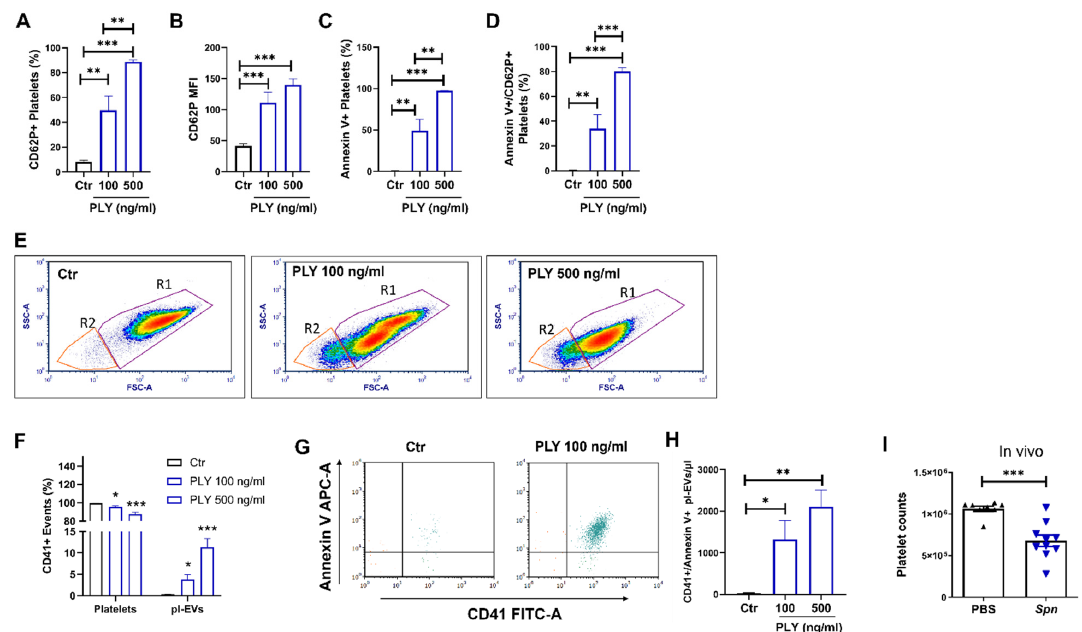
Figure 5. Pneumolysin activates platelets and induces the release extracellular vesicles (pl-Evs). ( A – H ) Human platelets (diluted PRP) were stimulated with PLY (100 or 500 ng/mL, 30 min), stained with CD62P (PerCP) antibody or annexin V (APC), and then analyzed by flow cytometry. ( A ) Percentage of CD62P positive platelets, ( B ) Median fluorescence intensity (MFI) of CD62P, ( C ) Percentage of annexin V positive platelets, and ( D ) Percentage of CD62P/annexin V double-positive platelets. ( E ) Representative FSC versus SSC dot plots of resting platelets (Ctr) or platelets treated with PLY (100 or 500 ng/mL). R1 gate includes platelets and R2 gate includes pl-EVs. ( F ) Quantification of the percentage of platelets and pl- EVs for each condition. ( G ) Representative dot plots of pl-EVs (gate R2; ( E )) and ( H ) corresponding quantification of EVs from Ctr or PLY-treated platelets (CD41/annexin V double positive). ( I ) Platelet counts in whole blood of mice infected with S. pneumoniae ( Spn ) (48 h). * p < 0.05, ** p < 0.01, *** p < 0.001. ( A – H ) n = 7–9, one-way ANOVA, ( F ) comparisons are vs. corresponding controls, ( I ) n = 8–10 mice per condition, Mann–Whitney test.